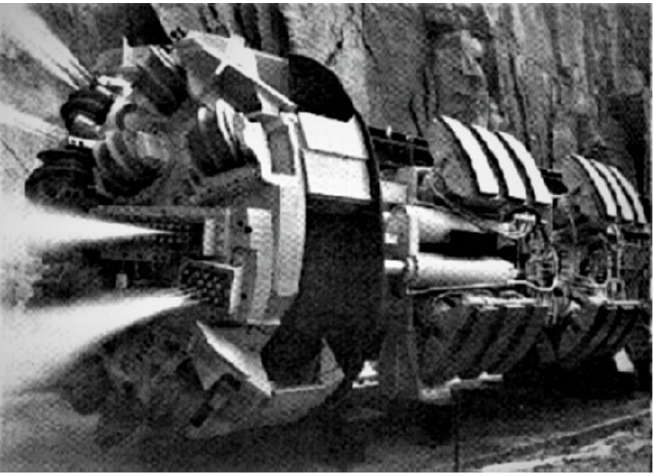
Figure 6. View of a Wirth TBM, model TB-I-260, with HPW jet assistance [7].